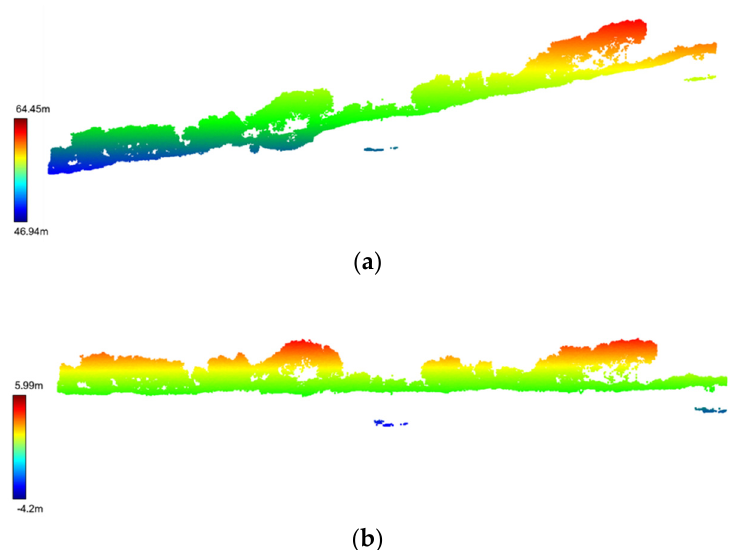
Figure 15. Illustrations of ( a ) original and ( b ) normalized point clouds for a sample profile (colored by height).